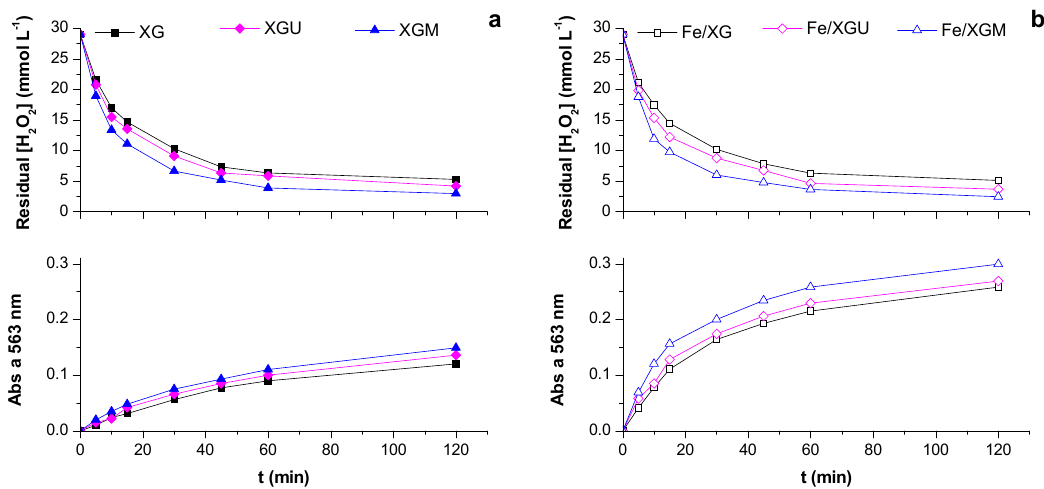
Figure 7. Consumption of hydrogen peroxide and hydroxyl radicals formation as a function of time for blank reaction with supports—xerogel (XG), XGU and XGM ( a ) and with catalysts—Fe/XG, Fe/XGU and Fe/XGM ( b ) (pH = 3.0, T = 30 °C, [support or catalyst] = 0.25 g L −1 , [H 2 O 2 ] = 29 mmol L −1 , [PNP] blank run = 0 mmol L −1 ).